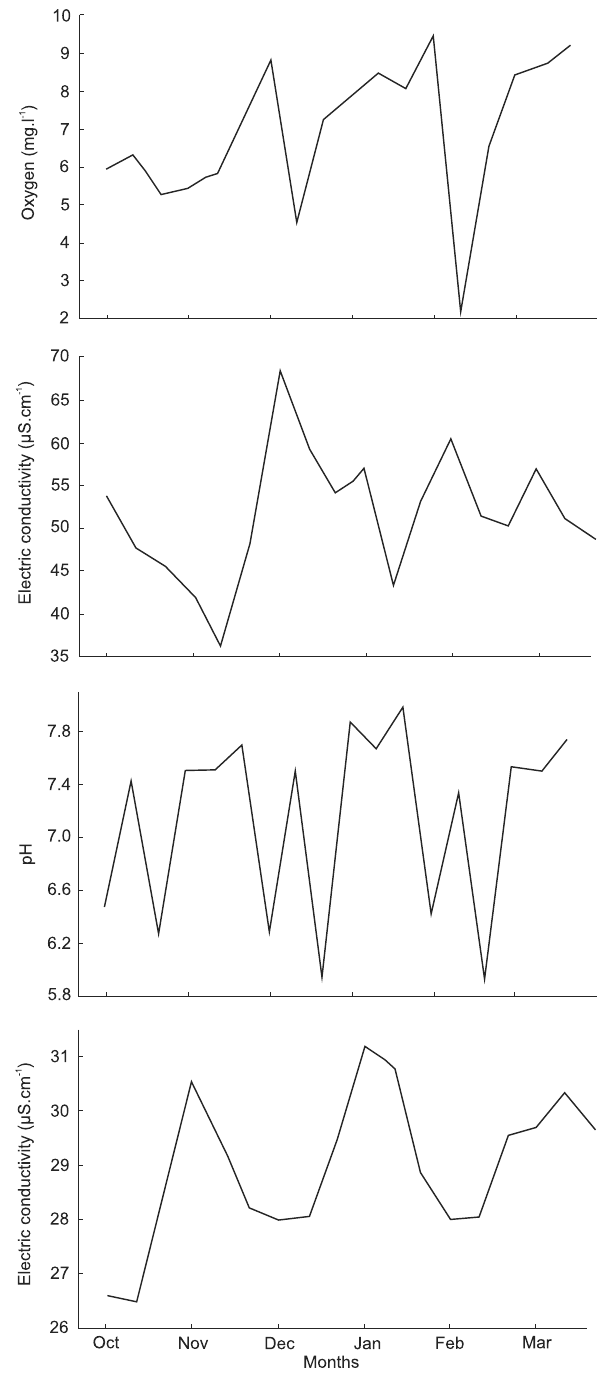
Figure 3. Values of the data of abiotic factors (pH, dissolved oxy- gen (mg.l -1 ), electric conductivity (µS.cm -1 ) and water tempera- ture (°C), per sampling point, in the region of Ilha Grande Na- tional Park, in Paraná River.